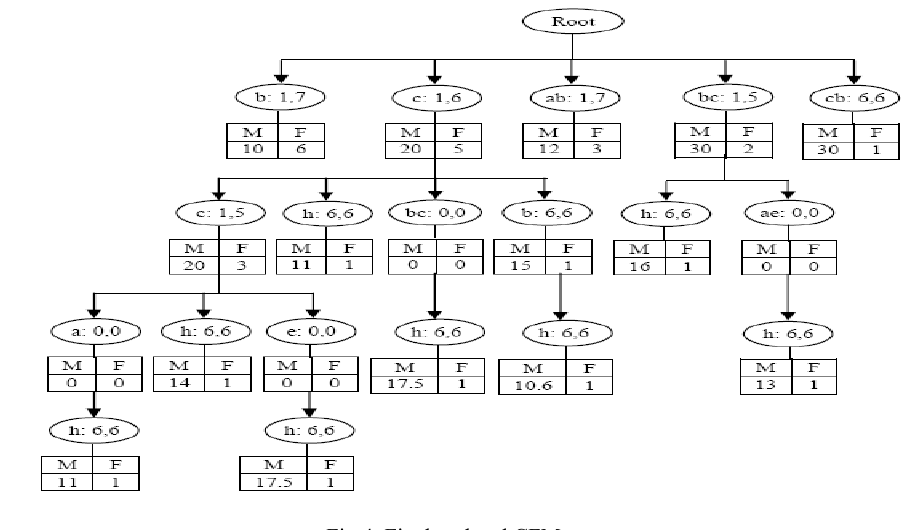
Fig.4. Final updated CFM-tree